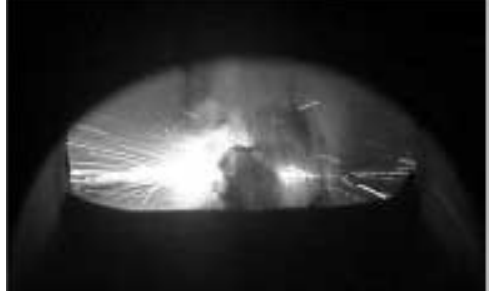
Fig. 14 Focus zone during operation.